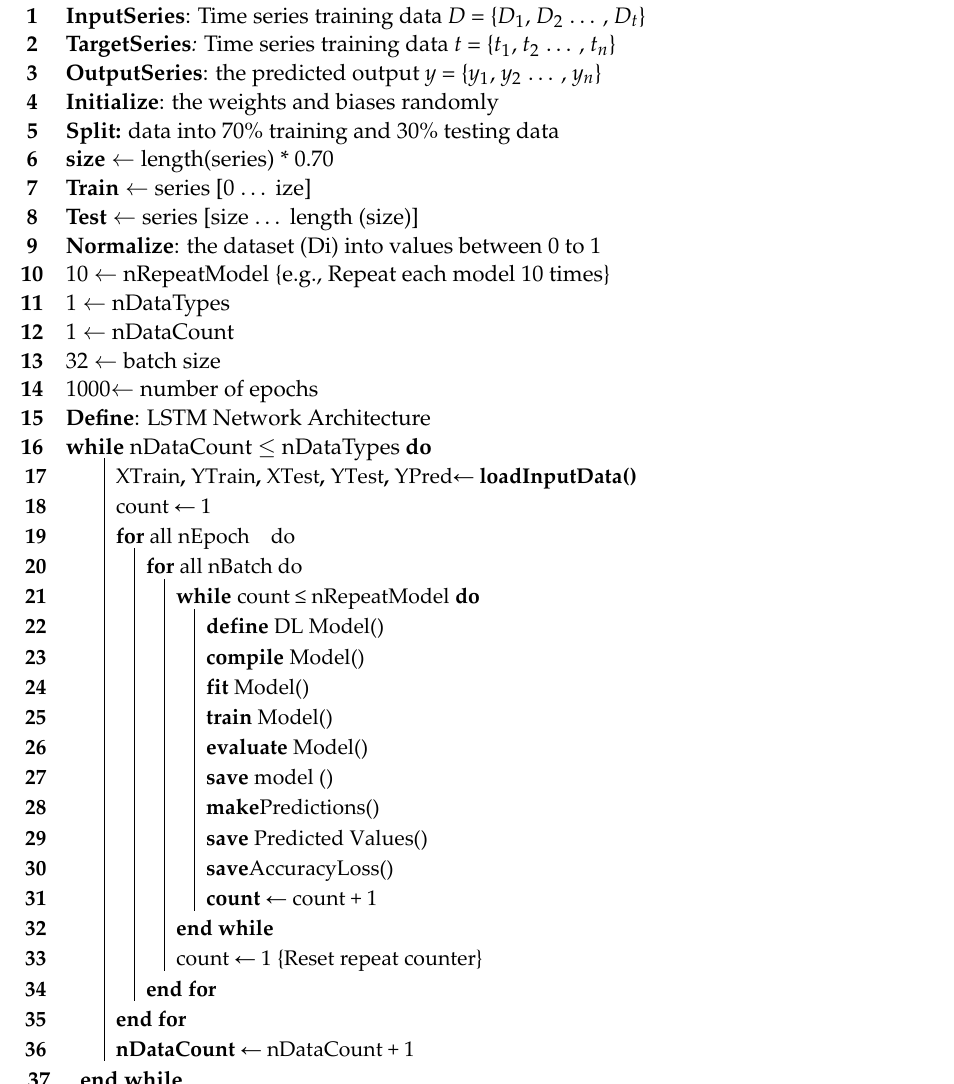
Algorithm1 : Prediction using Deep Learning-LSTM network